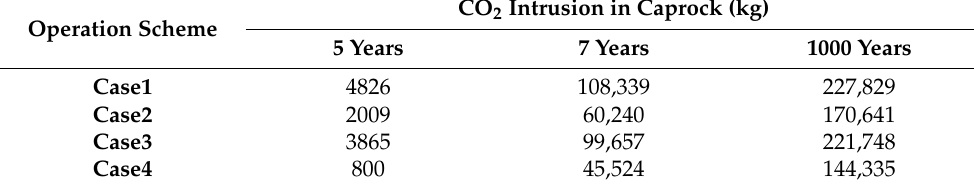
Table 5. Scheme running result.